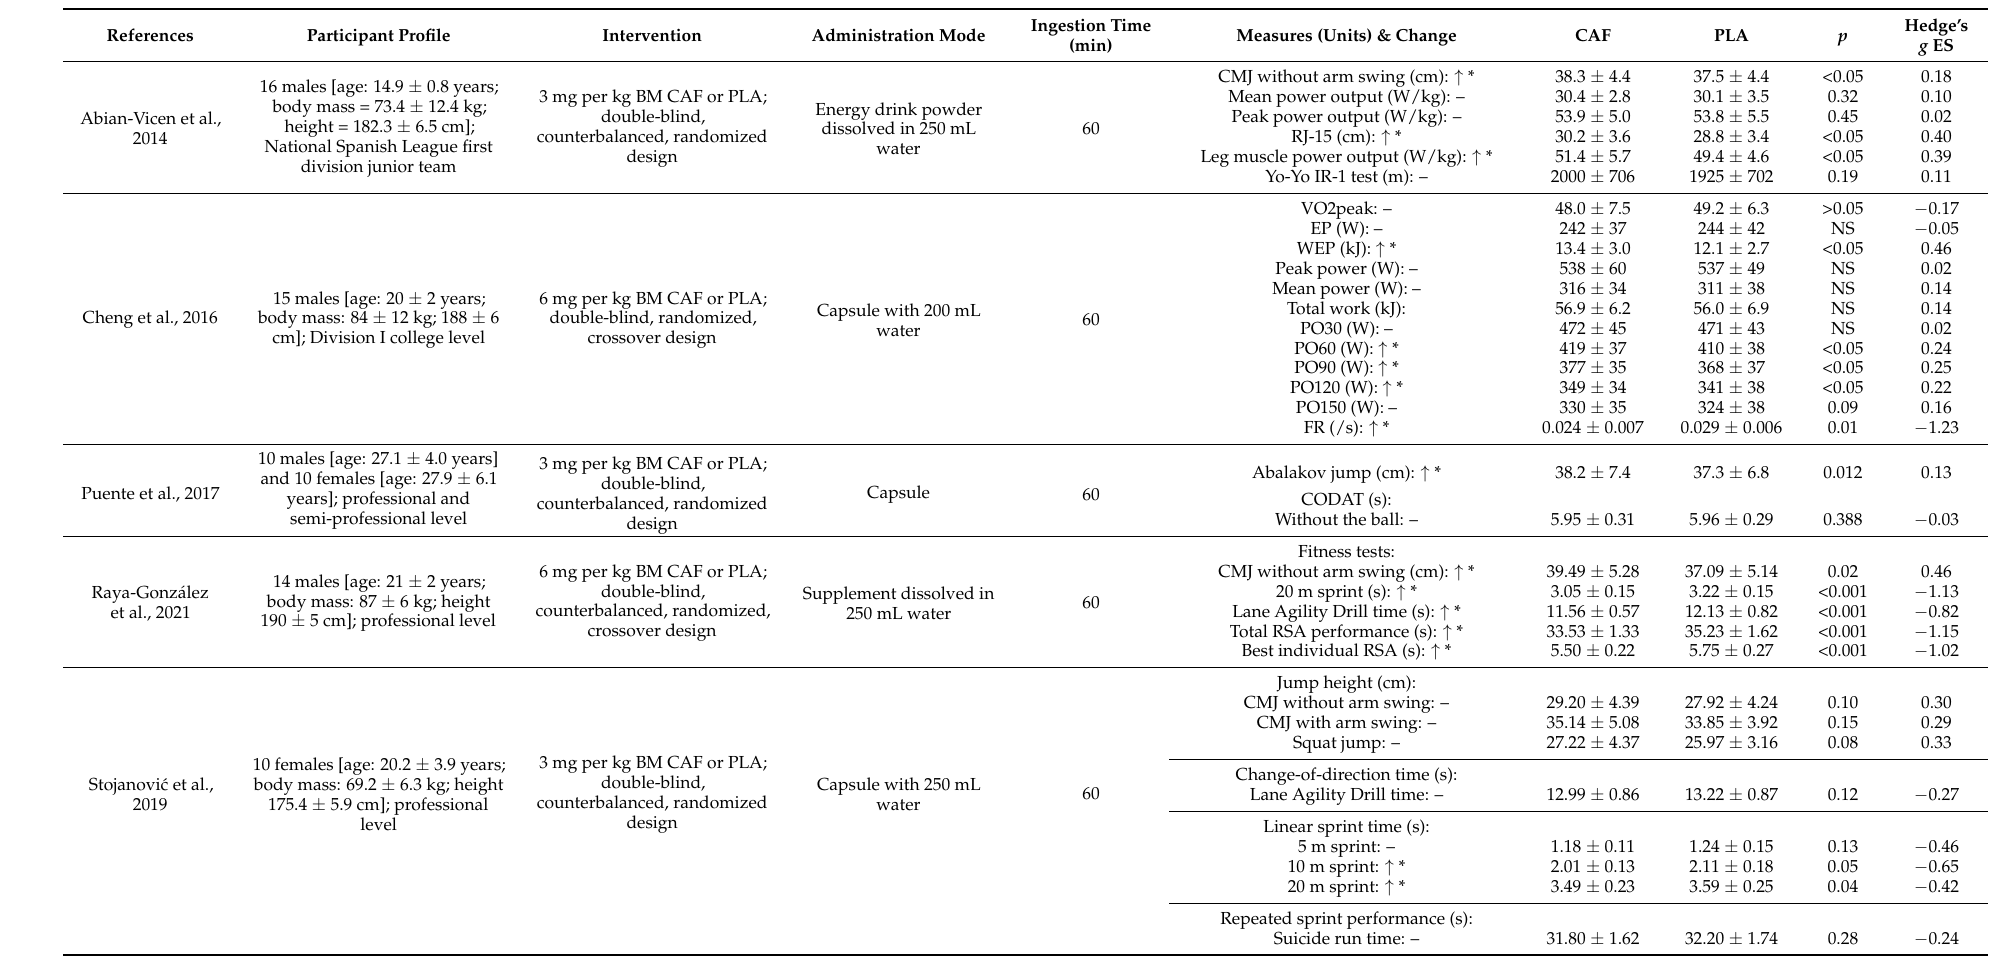
Table 3. Effect of caffeine supplementation on physical performances of basketball